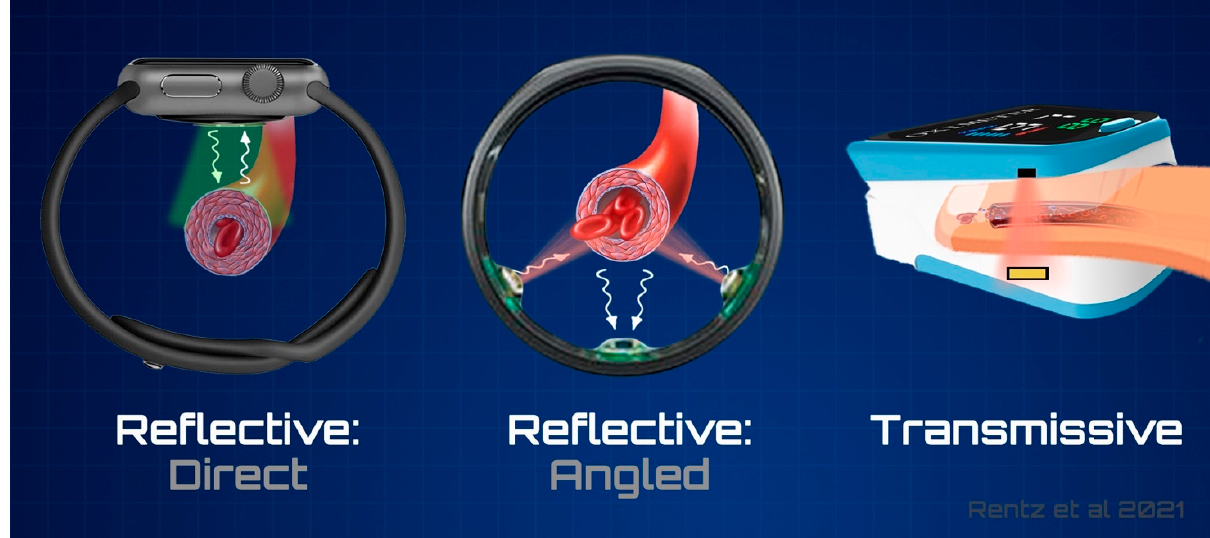
Figure 2. Arrangements of Photoplethysmography (PPG) Sensor Components. The two primary arrangements of PPG sensors, Reflective and Transmissive, as they pertain to the position of the light source and sensor in relation to target blood vessels. Reflective arrangements are further segregated based upon the relative positioning of the light source and sensor as either direct or angled.